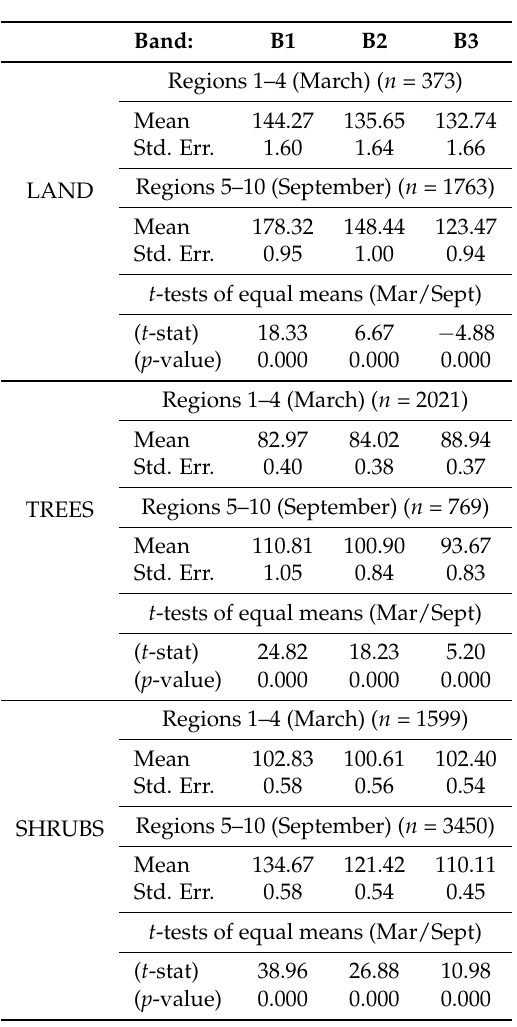
Table A4. Statistics for WorldView reflectance values of training data set, per class and season ( p -values shown for 95% confidence interval).